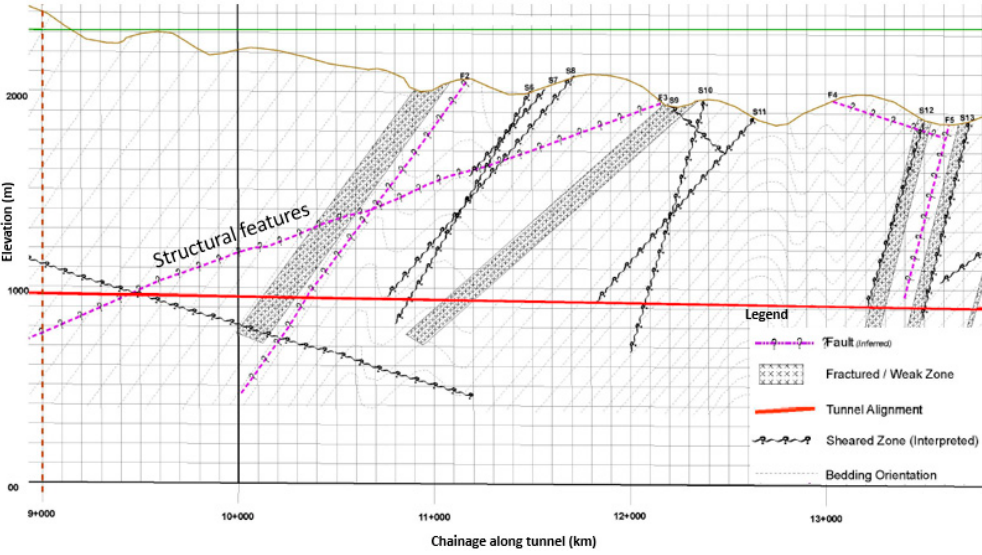
Figure 1. Geological map of the headrace tunnel area.